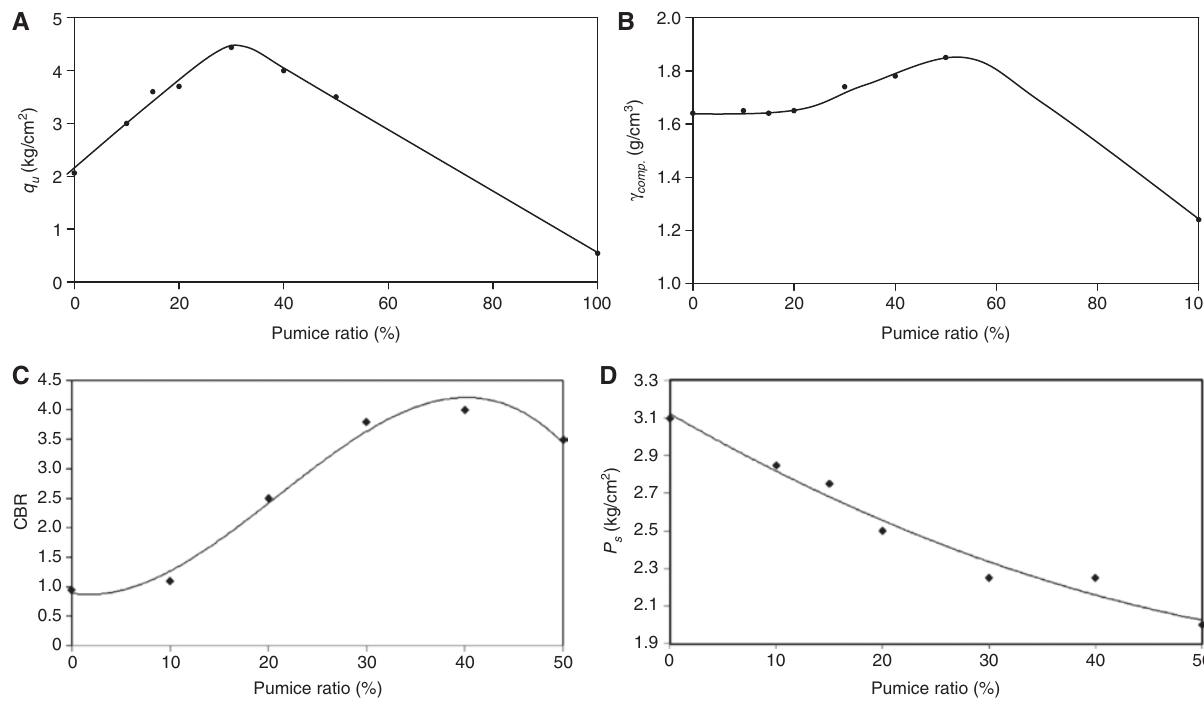
Figure 7 Effect of pumice ratio at the mixtures. (A) q , unconfined compressive strength. (B) γ u